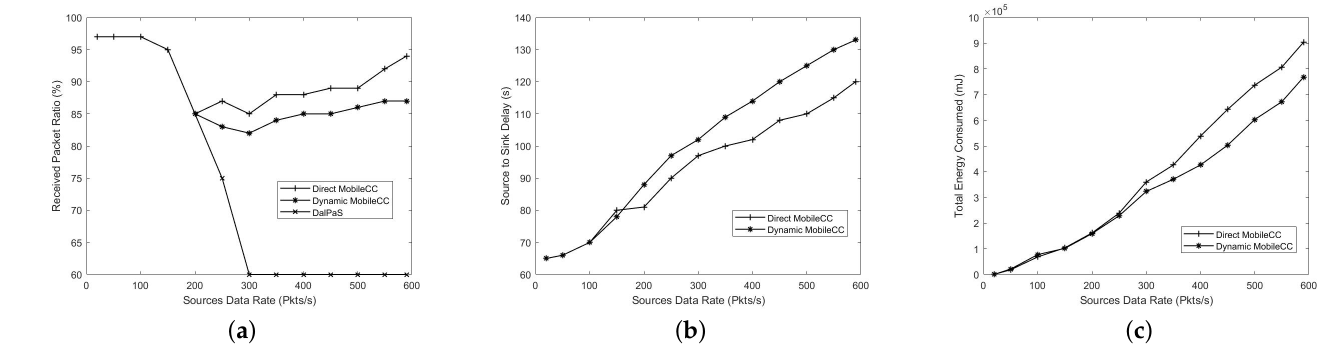
Figure 9. Evaluation graphs of the NPA algorithm. ( a ) Average Throughput, ( b ) Source to Sink Delay, ( c ) Total Energy